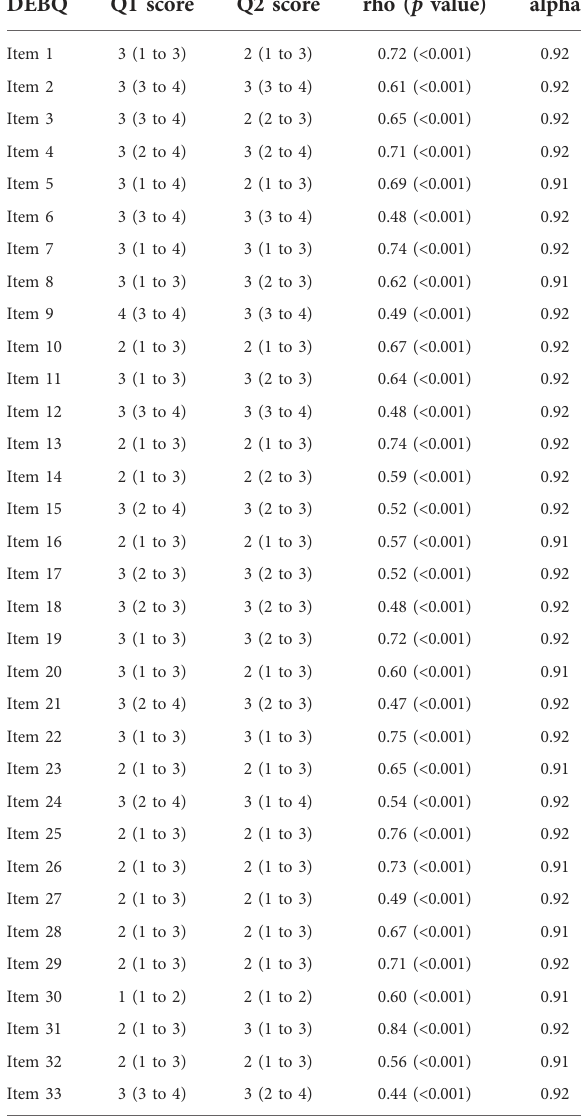
Table 2 Reliability of the Dutch Eating Behavior Questionnaire (DEBQ).